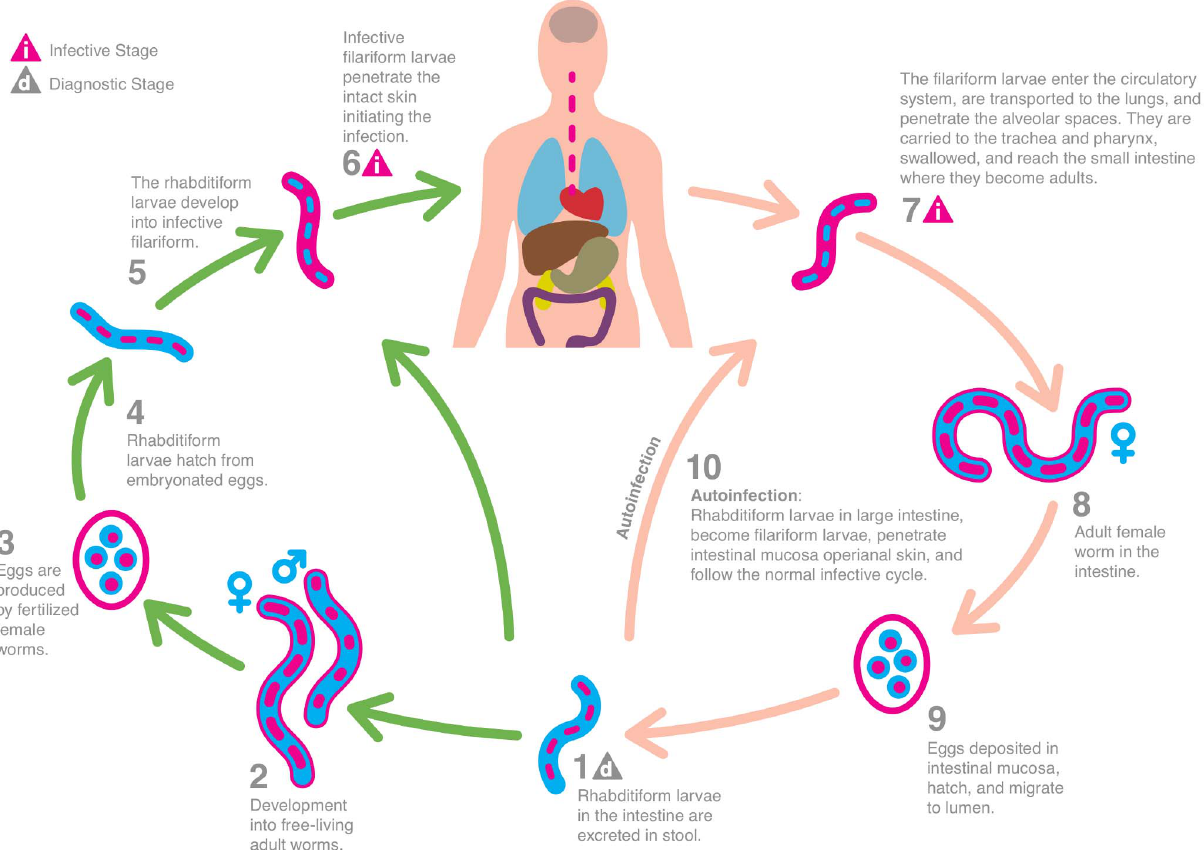
Figure 1. The life-cycle of S.stercoralis (based on http://www.dpd.cdc.gov/dpdx).